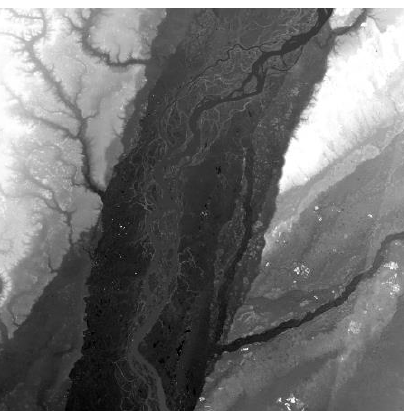
Figure 5. AW3D30 product covering Laser data of the 755 th track